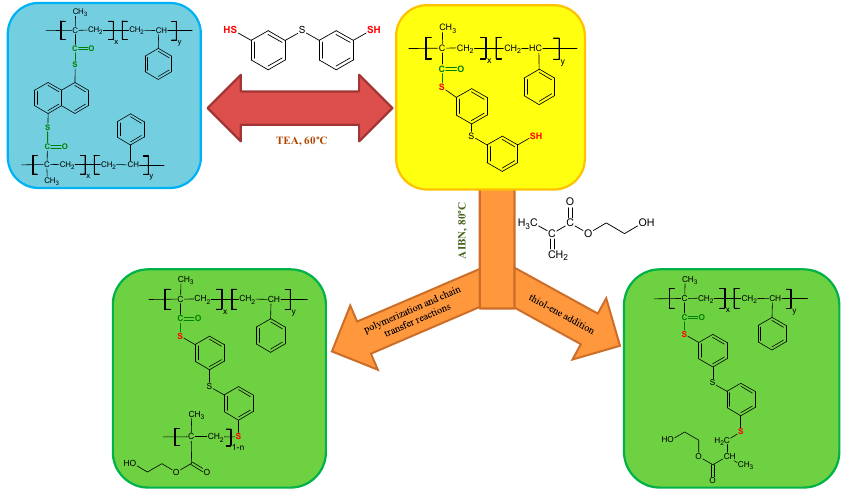
Figure 2. Scheme of thiol-thioester exchange and possible reaction pathways for the thiol-methacrylate system in our studies.